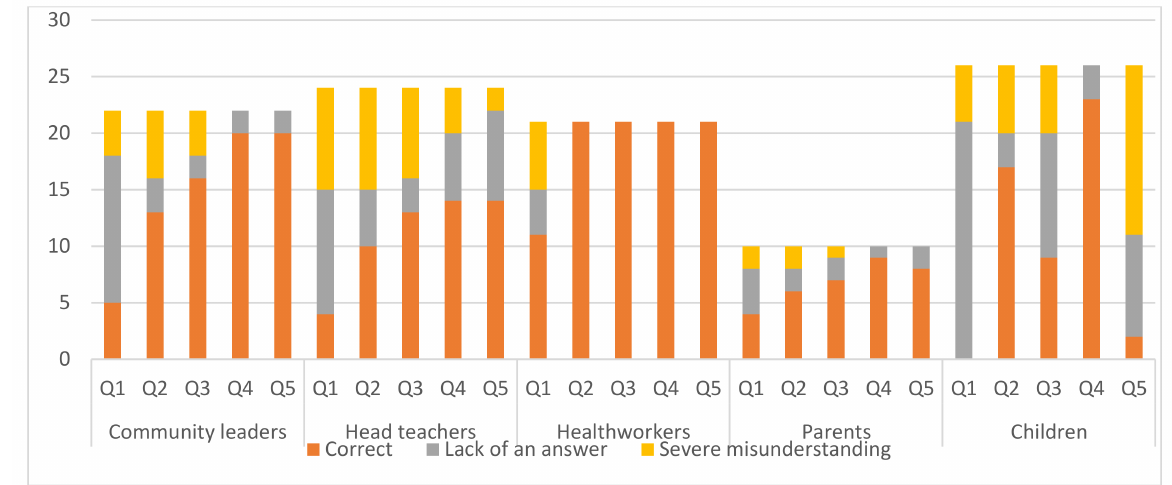
Figure 1. Knowledge on Human Papilloma Viruses (HPVs) infections, HPV vaccination and cervical cancer. The figure shows the number of participants in each category ( y -axis) and their responses (correct in orange, lack of an answer in grey and severe misunderstanding in yellow) to the questions asked to assess their knowledge. Q1, Question 1: What is HPV; Q2, Question 2: Goal of HPV vaccination; Q3, Question 3: Prevention of Cervical cancer and HPV; Q4, Question4: Risks of catching HPV; Q5, Question 5: What is cervical